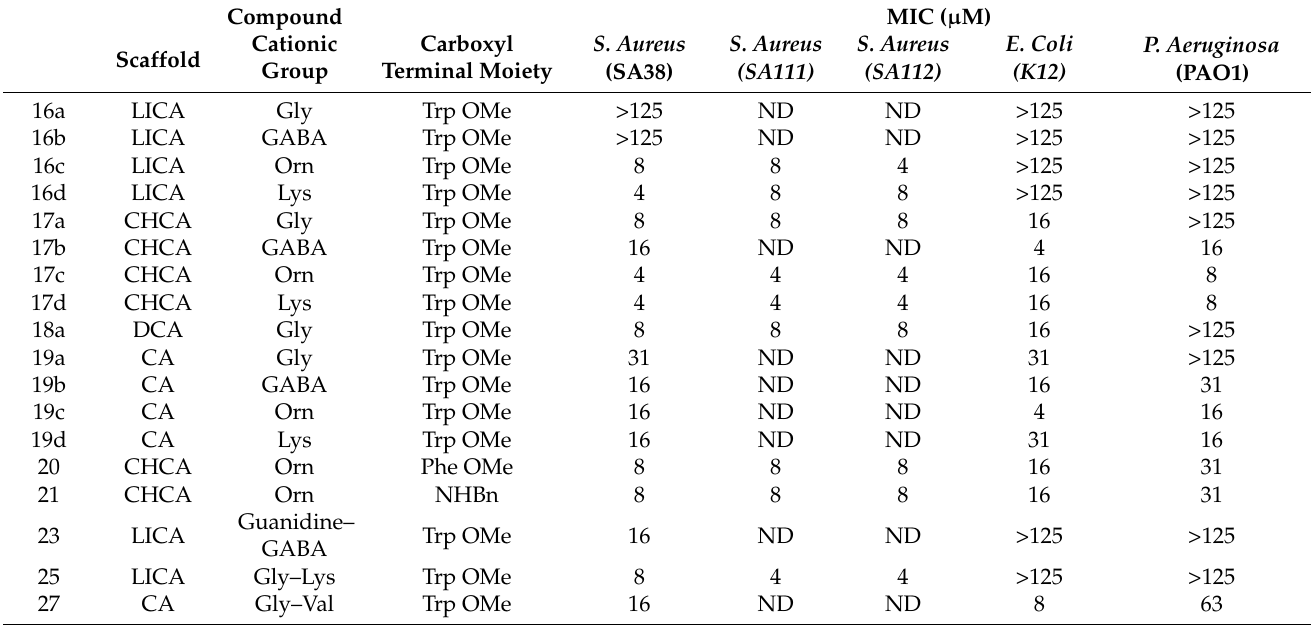
Table 1. Minimum inhibitory concentration of compounds against S. aureus and E. coli . (ND = Not